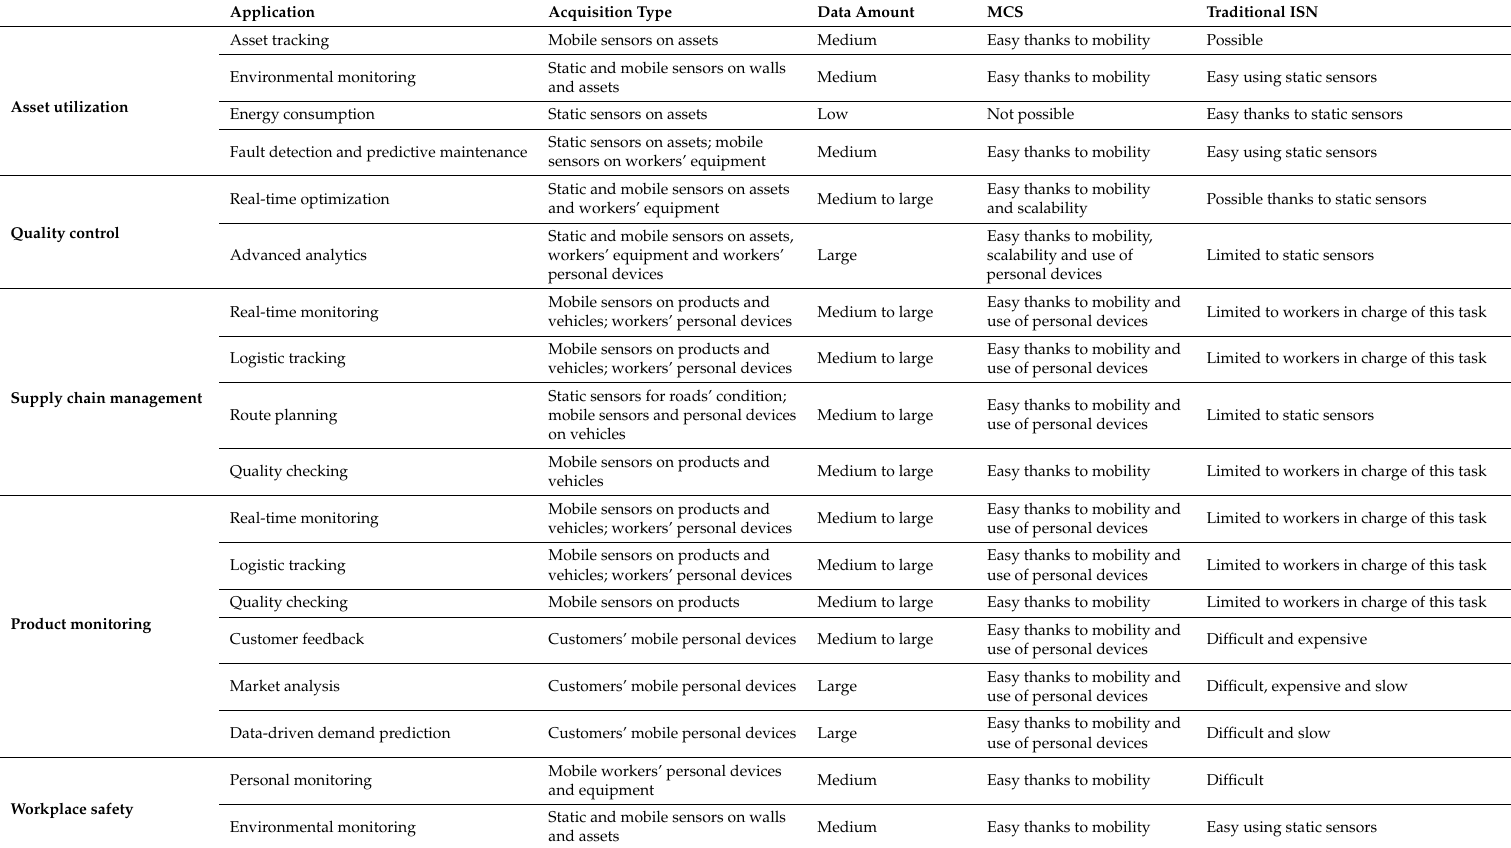
Table 1. Industrial applications using MCS (mobile crowdsensing and mobile crowdsourcing) and traditional ISNs (Industrial Sensor